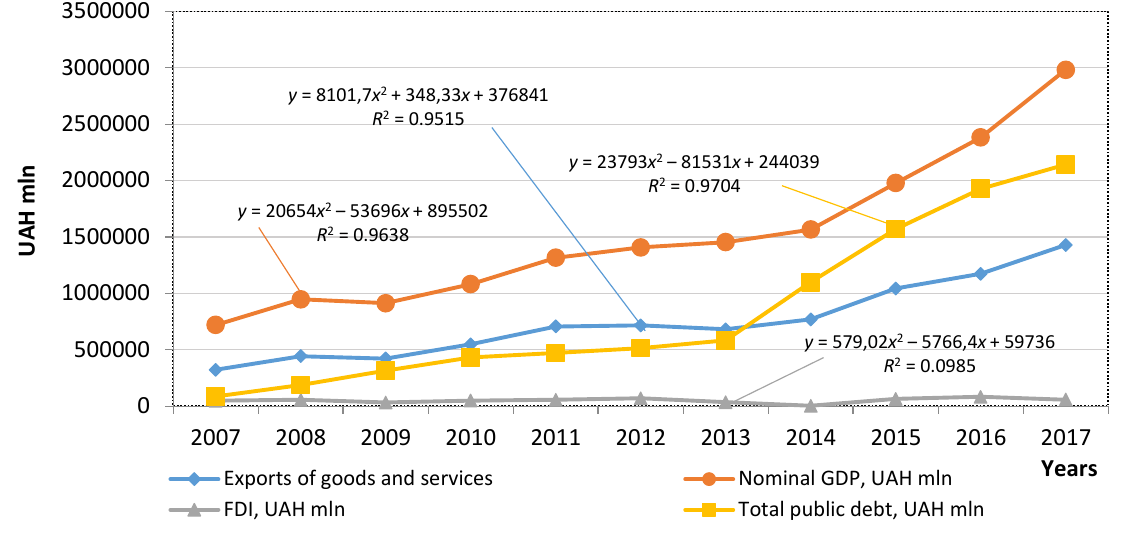
Figure 4. Influence of social system constituents on GDP